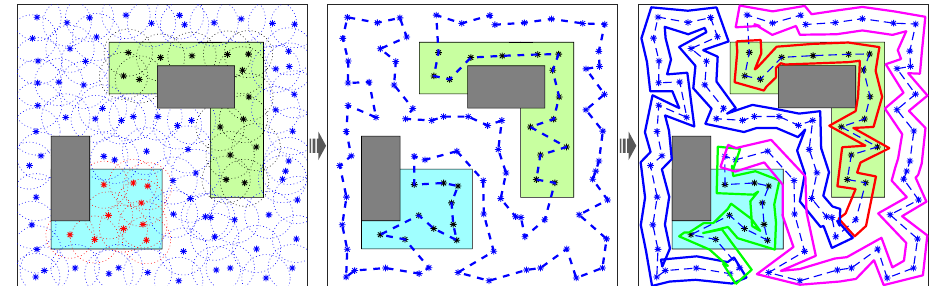
Figure 12. The solution process of the combinatorial method for multi-robot persistent coverage. The cyan area is sub-region 1. The green area is sub-region 2. The white area is sub-region 3. Gray areas refer to obstacles. The asterisk denotes the position of the sensor. The blue dotted line is the frame. Solid curve represents the closed route for each robot.